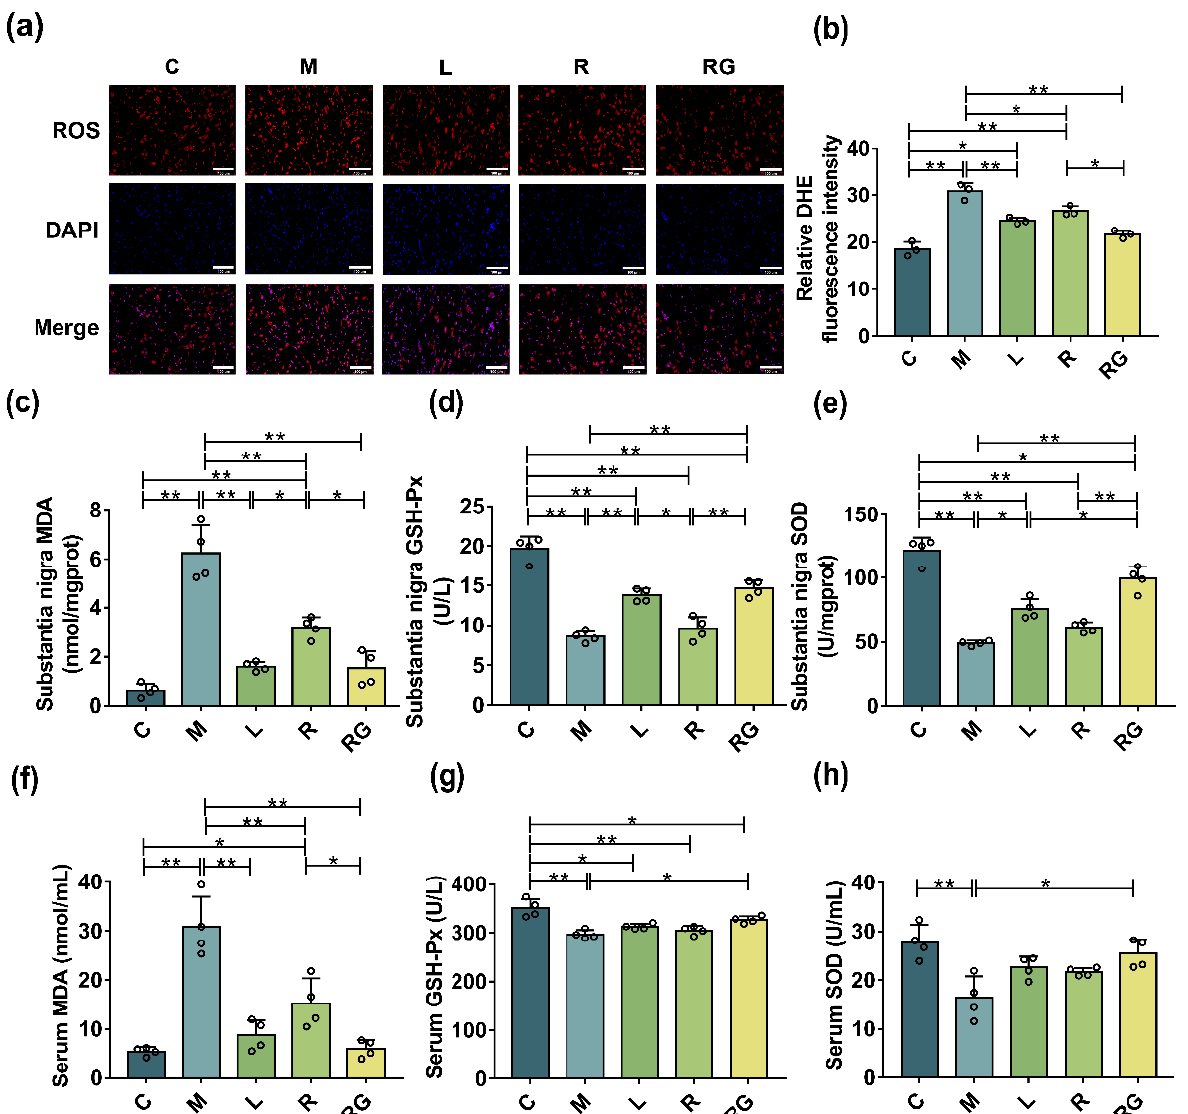
Figure 5. L. lactis MG1363-pMG36e-GLP-1 reduced systematic and SN oxidative stress in PD model mice. ( a ) Levels of ROS in SN of PD model mice as measured by DHE staining (scale bar = 100 µ